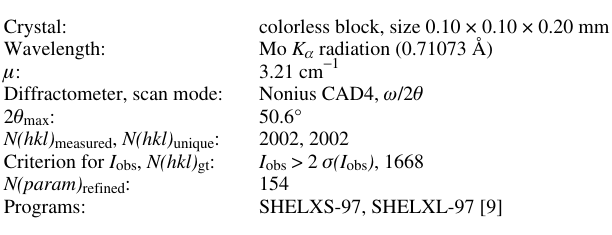
Table 1. Data collection and handling.